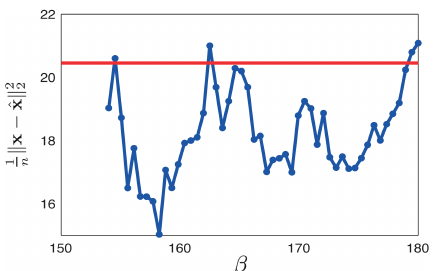
Figure 8. Sensibility of TRANSAC combined with Tikhonov regu- larization to the parameter β . The red line indicates the estimation error given by typical Tikhonov (Eq. 2). The algorithm is sensitive to beta, but, for practically all beta values, the performance is im- proved.